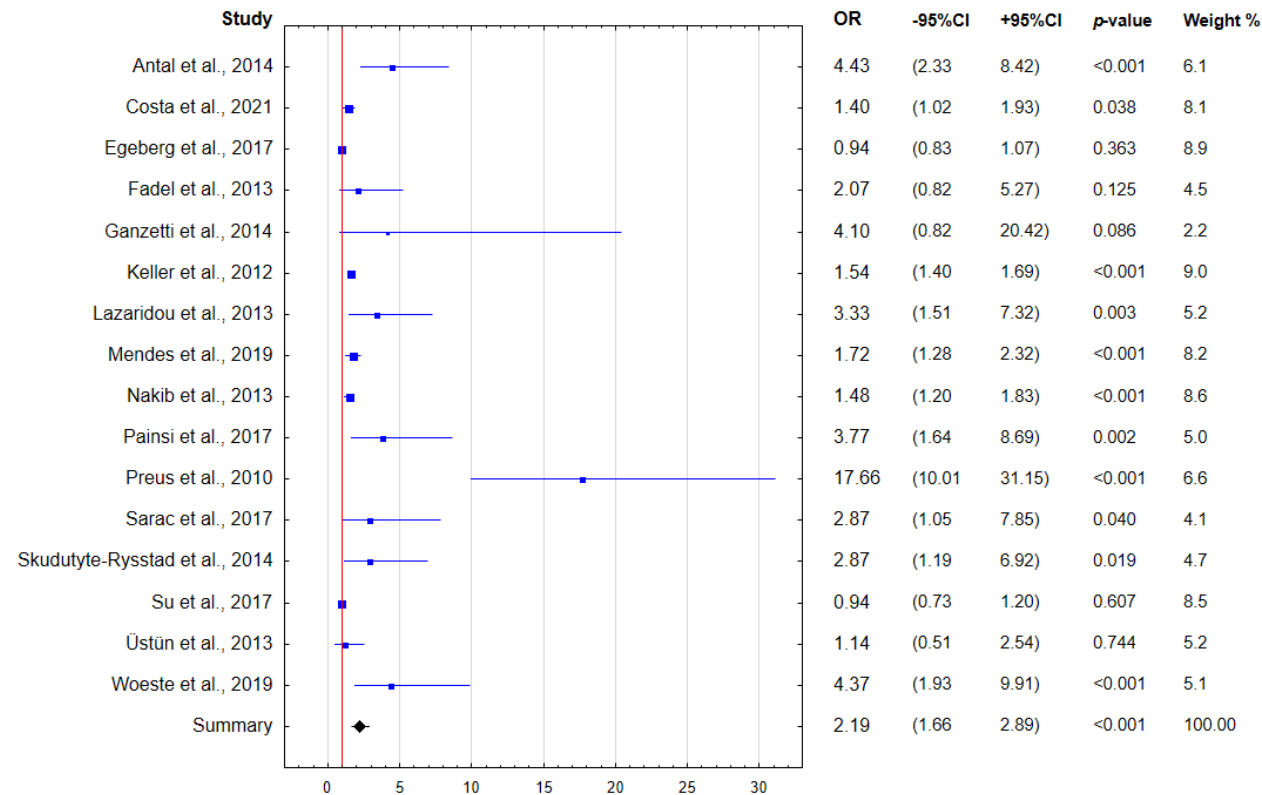
Figure 3. Forest plot presenting the pooled prevalence of periodontal disease in patients with pso- riasis [33–35,40–52].